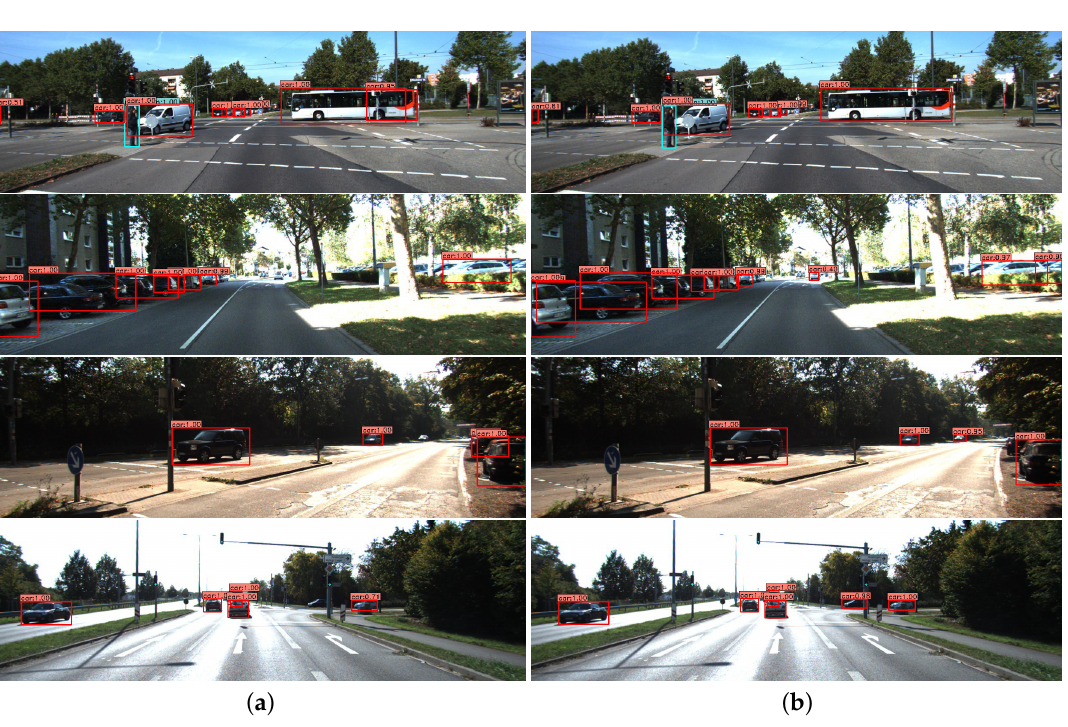
Figure 4. Detection examples on KITTI dataset with FPN and EFPN model. For each pair, on the left is the result of FPN ( a ) and on the right is the result of EFPN ( b ). We show detections with scores higher than